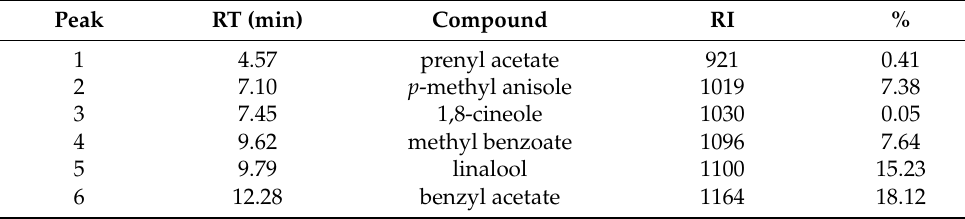
Table 1. Chemical composition of Cananga odorata essential